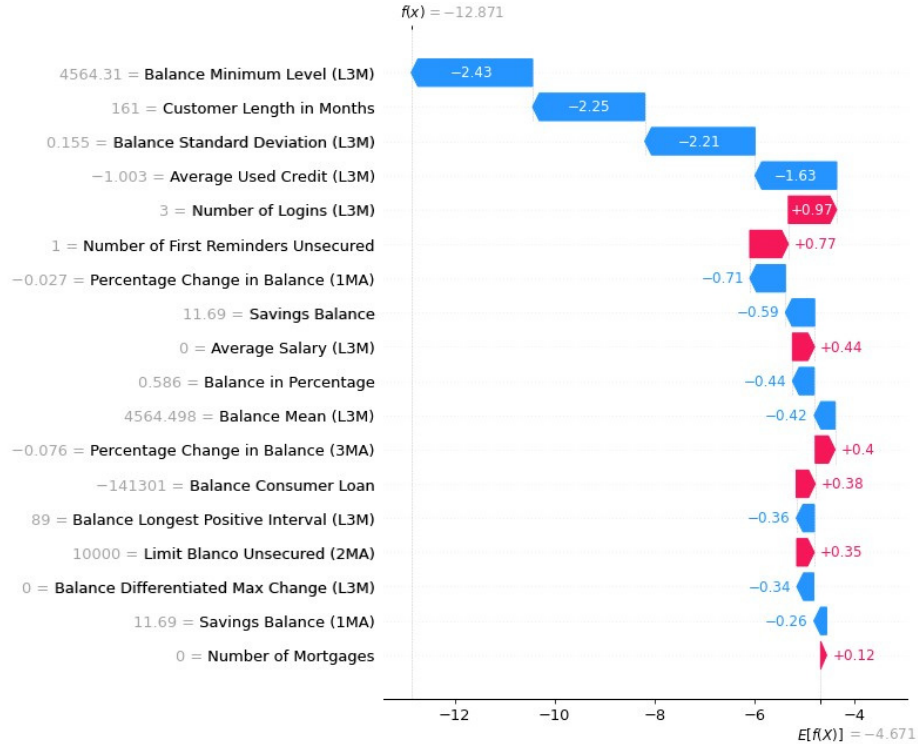
Figure 13. SHAP waterfall plot visualizing the predicted feature contributions to a non-defaulting customer. All values are in log odds. The prediction by the model, f ( x ) , corresponds to a probability of 0.0003%. The bias of the LightGBM model is displayed as E [ f ( x )]